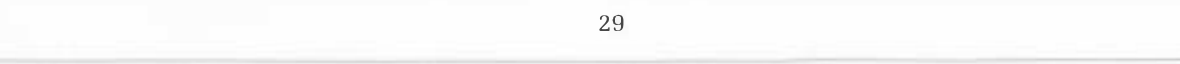
Figure 3 Contemporary photograph of Pumpelly's excavation beginning on the north kurgan at Anau in 1 904 (seen. 4: p.